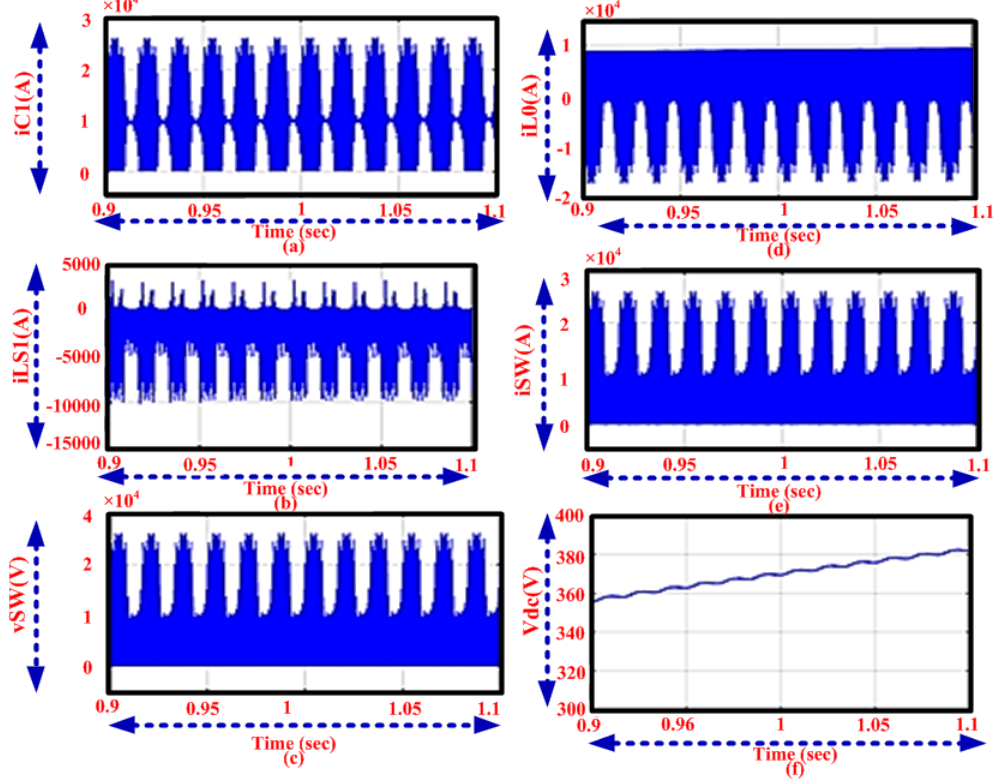
Figure 12. Analysis of current using the ( a ) C 1 , ( b ) L 1 , ( d ) L 0 , ( e ) switch and voltage using ( c ) switch, ( f ) DC